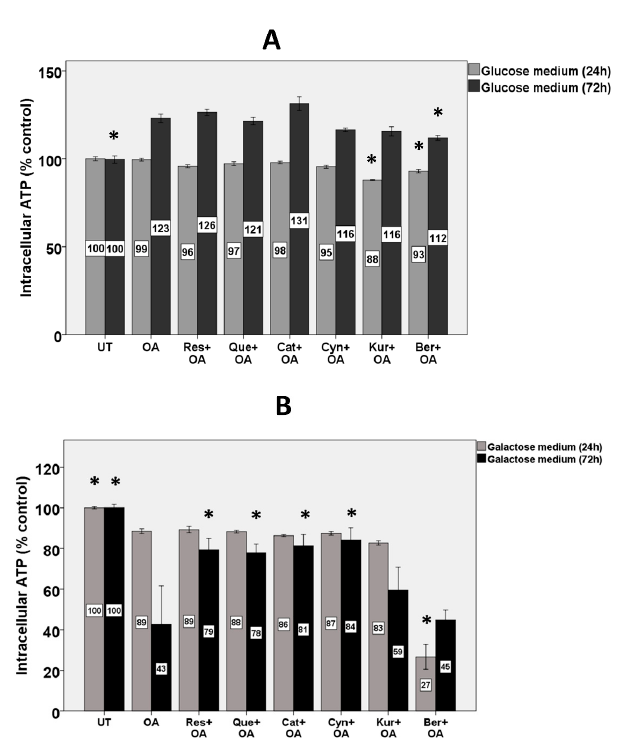
Figure 5. Effects on ATP stores in HepG2 cells grown in glucose and galactose medium. HepG2 cells were grown in ( A ) glucose (5.5 mM) and ( B ) galactose medium (25 mM) and were treated with 10 µ M polyphenols for 2 h and 1.5 mM OA for 24 and 72 h. Untreated cells were set at 100% and data are presented as % of the untreated cells. The bars represent means ± SEM of three independent experiments with three wells of cells in each experiment. (*) Significantly different from the OA alone condition at p <0.05.